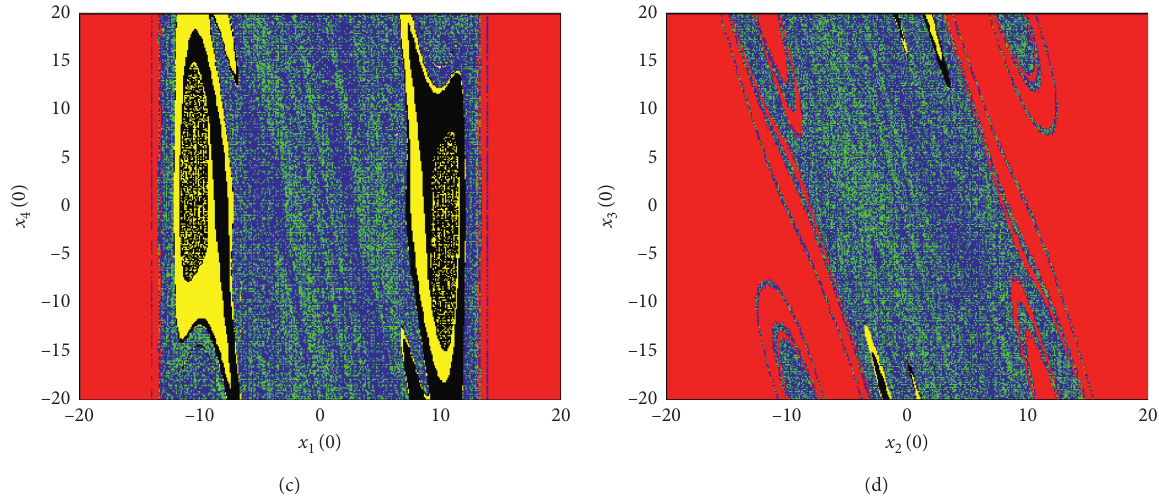
Figure 15: Cross sections of basin of attraction for x ( 0 ) � x ( 0 ) � 0, x ( 0 ) � x ( 0 ) � 0, x ( 0 ) � x ( 0 ) � 0, and x ( 0 ) � x ( 0 ) � 0 3 4 2 4 2 3 1 4 corresponding to the asymmetric pair of chaotic (blue and green) and period-2 attractors (yellow and black) obtained for c � 2 . 44. Red regions correspond to unbounded motion. Table 4: Details of the coexistences observed in the novel hyperjerk system. Values of control Fig.n 0 Type of coexistences parameter A symmetric pair of period-2 attractors, a symmetric pair of chaotic Figure 16 attractors, and a pair of fixed point. A symmetric pair of period-2 attractors, a symmetric pair of chaotic Figure 17 attractors, a symmetric pair of period-9 attractors, and a pair of fixed point. A symmetric pair of period-2 attractors, a fixed point, a symmetric pair of Figure 18 period-12 attractors, 2 symmetric pairs of chaotic attractors, and a pair of fixed point.